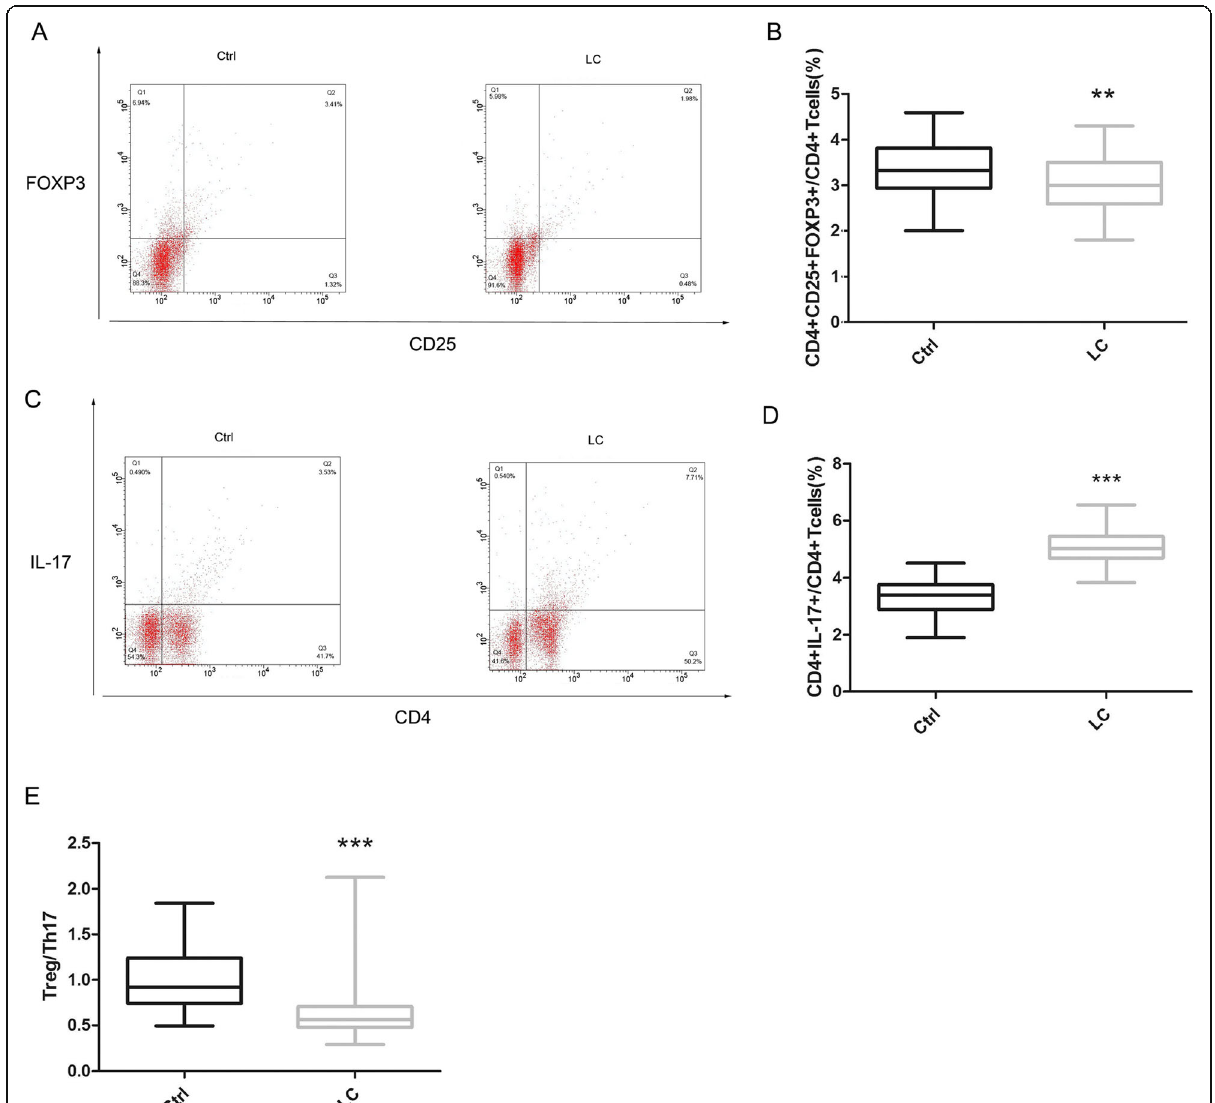
Fig. 1 Comparison of the incidence of Treg and Th17 cells and the Treg/Th17 ratio between the two groups. Ctrl refers to the control group, LC refers to the liver cirrhosis group. * p < 0.05, ** p < 0.01, *** p < 0.001. a Flow cytometric analysis of CD4 + CD25 + FOXP3 + Treg cells between the two groups. b Comparison of the percentage of CD4 + CD25 + FOXP3 + Treg cells in CD4 + T cells between the two groups ( p <0.01). c Flow cytometric analysis of CD4 + IL-17 + Th17 cells between the two groups. d Comparison of the percentage of CD4 + IL-17 + Th17 cells in CD4 + T cells between the two groups ( p <0.001). (E) Comparison of the Treg/Th17 ratio between the two groups ( p